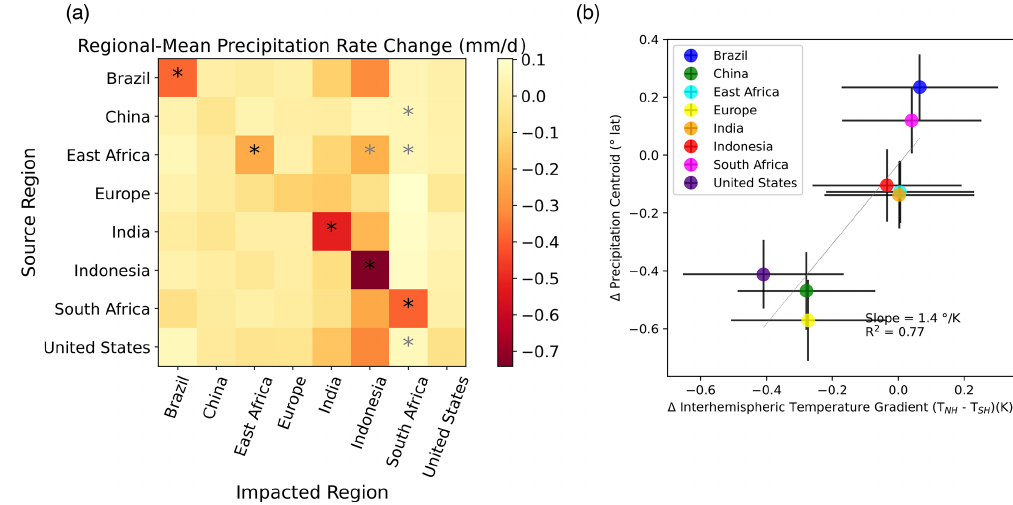
Figure A5. As in Fig. 4 but for the second simulation set conducted with adjusted initial conditions (see Sect. 2).